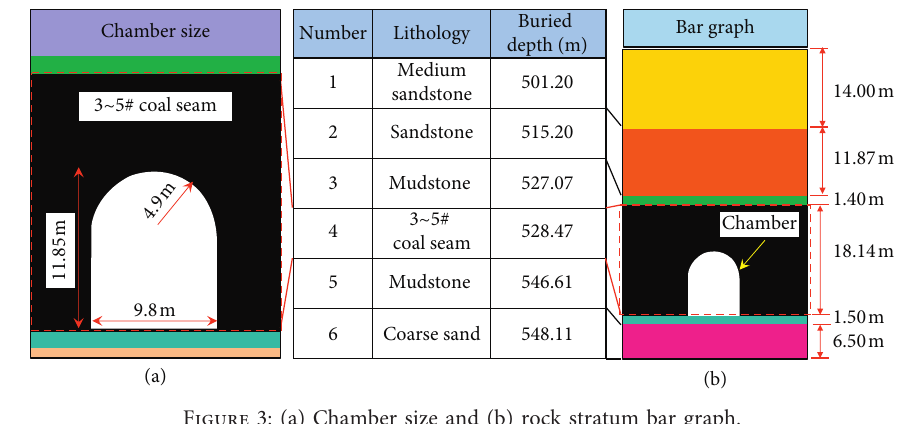
Figure 3: (a) Chamber size and (b) rock stratum bar graph.